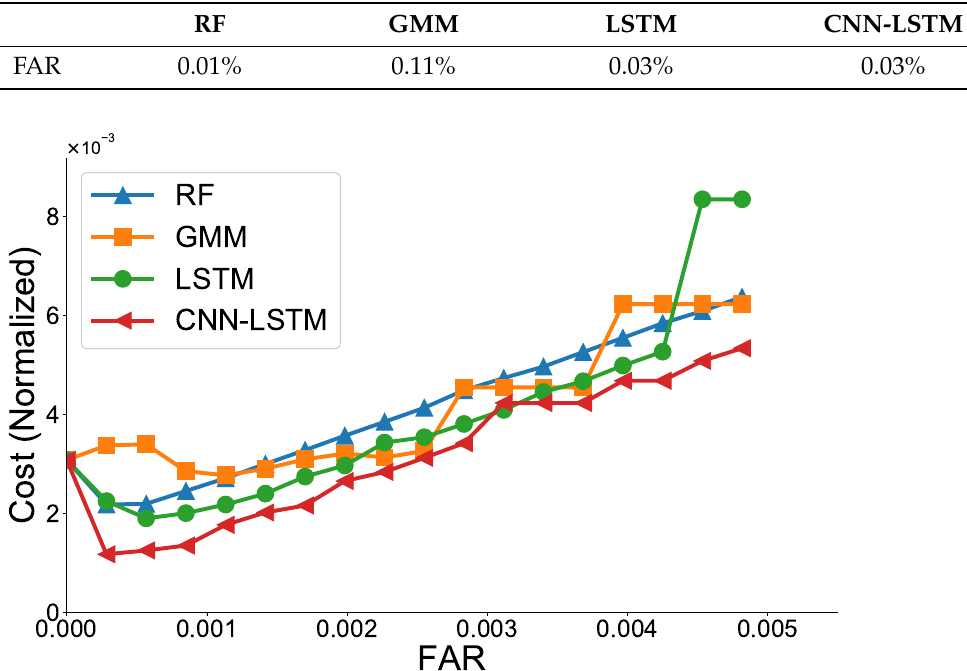
Figure 11. Normalized cost with respect to FAR for various ML